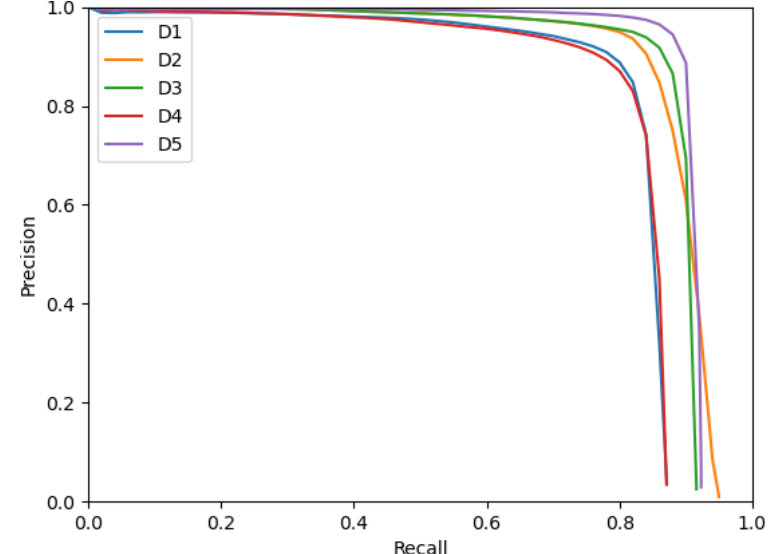
Figure 3. Precision–Recall curves for detectors with an IoU threshold of